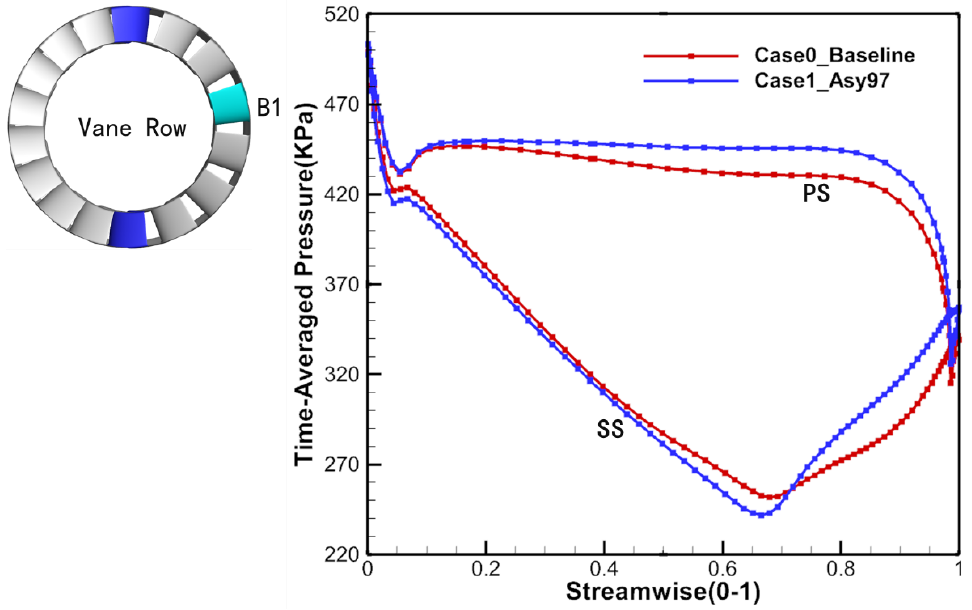
Figure 14. Time-averaged pressure distribution on the vane surface (midspan).